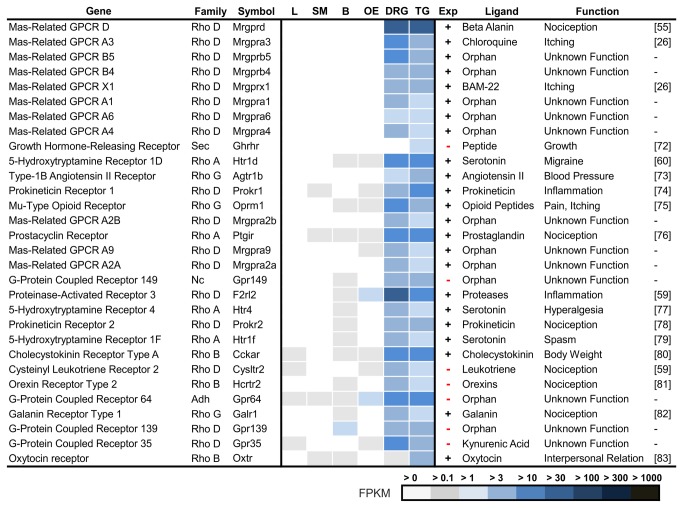
The most TG-specific GPCRs.GPCR genes are ranked according to their specific expression in the TG, which is calculated by the quotient of the FPKM values of TG and the mean FPKM values of brain (B), liver (L), olfactory epithelium (OE), and skeletal muscle (SM). Members of the Mrgprs are the most specific GPCRs that have been detected in the TG and DRG. Among the 30 most specific GPCRs, seven newly detected GPCRs in the TG were identified. Twelve of the most specifically detected GPCRs are still orphans and, based on their specific expression patterns in the TG and DRG, may be important for tissue-specific functions.